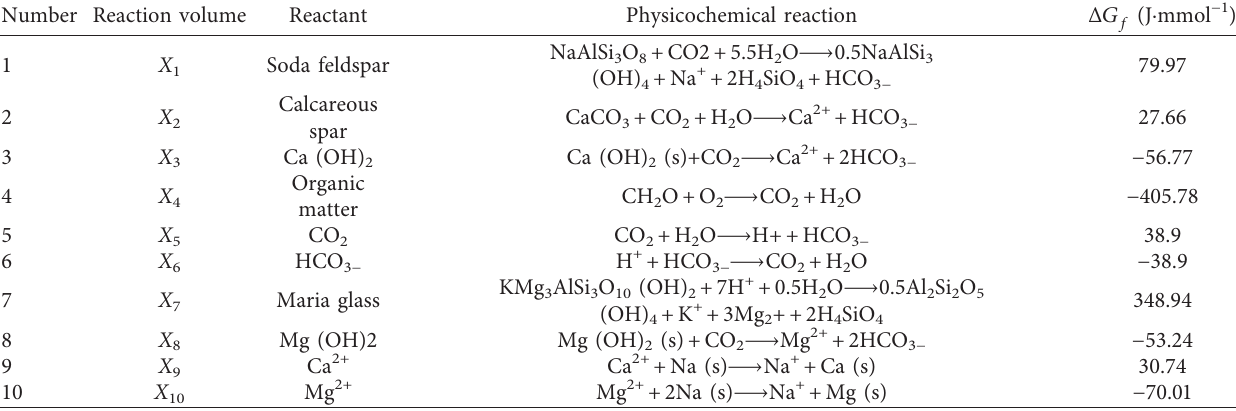
) of the water-rock system. f